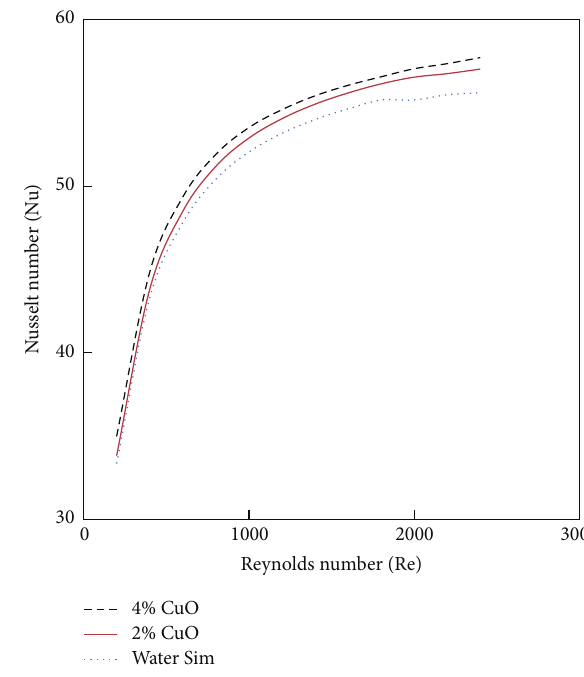
Figure 7: The effect of CuO nanofluid volume concentration on Nusselt number for CCT with twist ratio